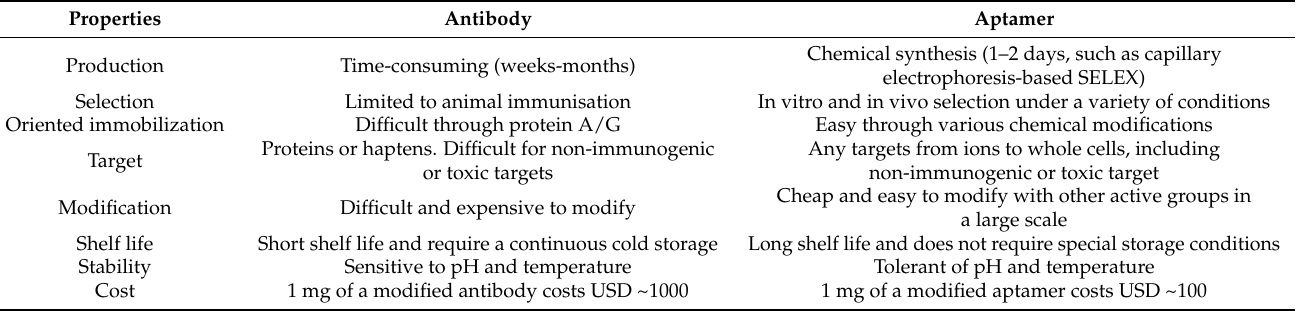
Table 3. Comparison of the properties of aptamers to antibodies (adopted from [96,111]). Properties